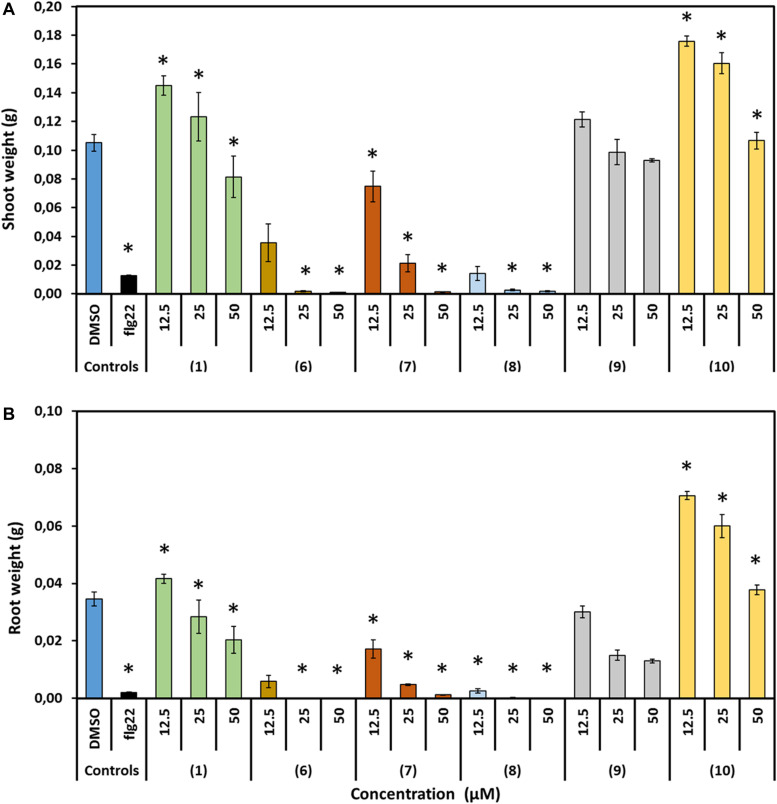
Effect of prodigiosin (1) and derivatives 6–10 on A. thaliana growth. Figures show growth parameters representing development of A. thaliana cultivated on media mixed with prodigiosin (1) or different derivatives (6–10) in three concentrations compared with those growing on medium mixed with DMSO as control. Flg22 (1 μM) treated plants served as controls for successful growth inhibition. (A) Average fresh shoot weight (g). (B) Average fresh root weight (g). Data are based on three independent experiments. Each bar represents the mean ± standard error of n = 15. Asterisks indicate significant differences to the control based on one-way ANOVA followed by Dunnett’s post-hoc test (P < 0.05).